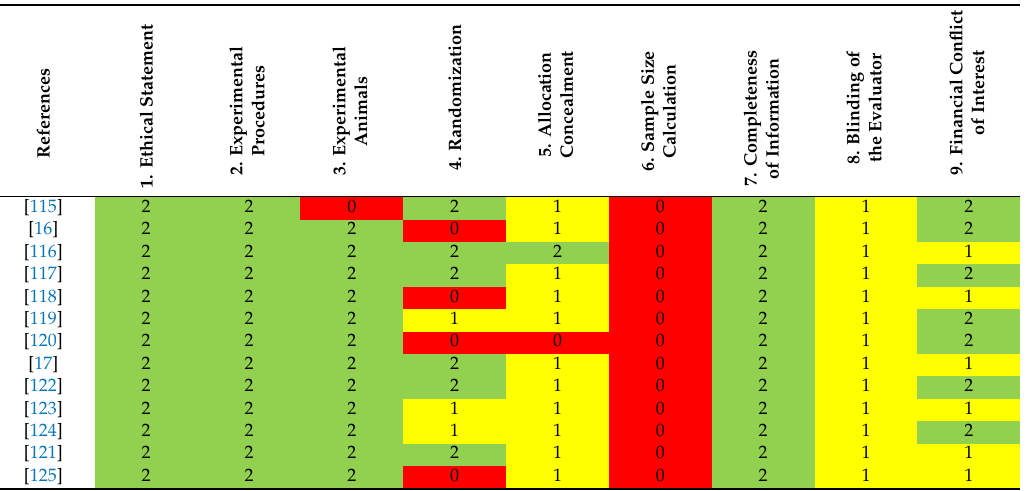
Table 7. Study quality